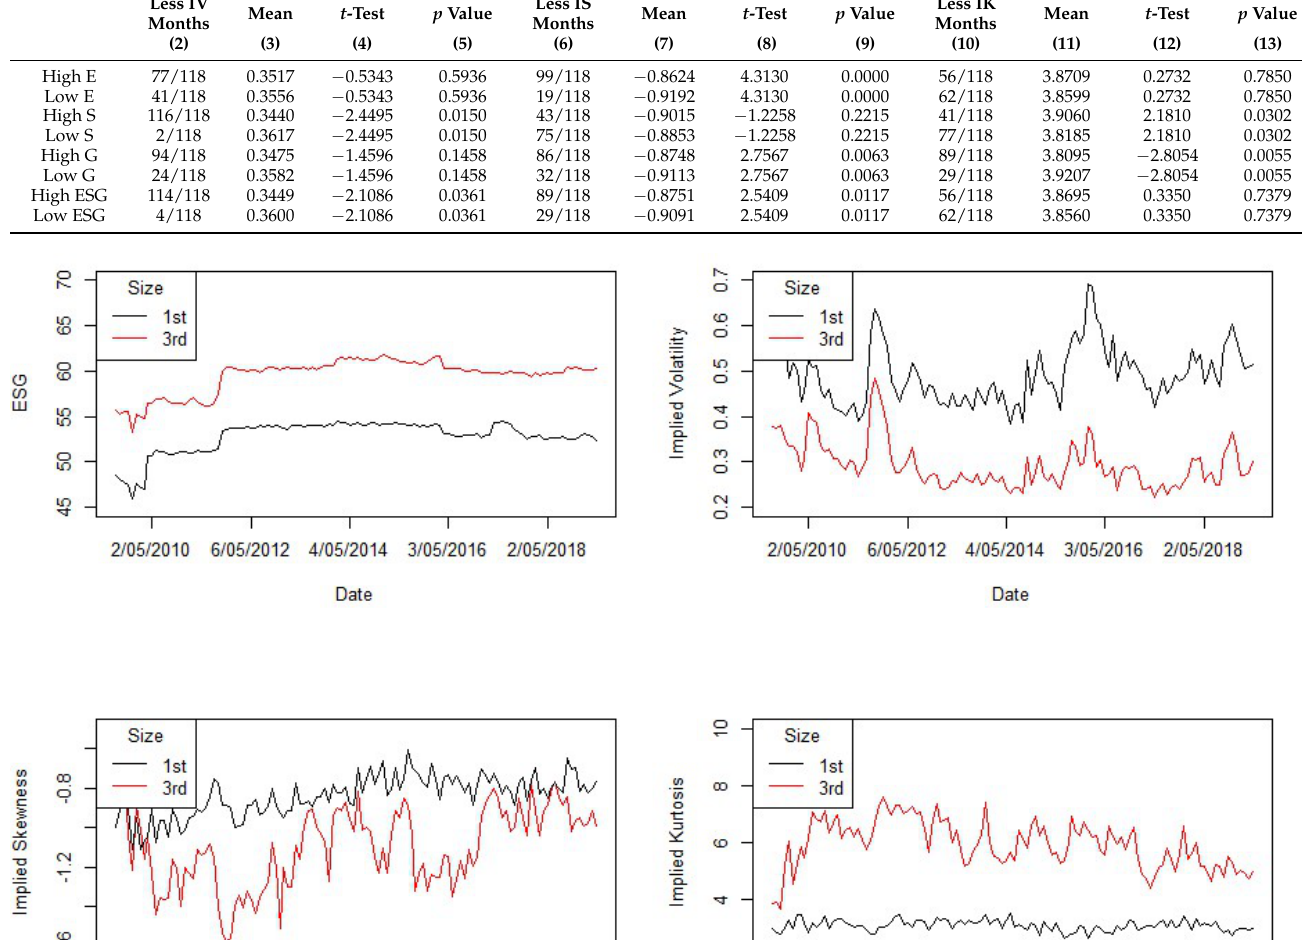
Table 3. Number of months during which the implied moments of mid-sized companies in either the high or the low ESG rating group was lower.